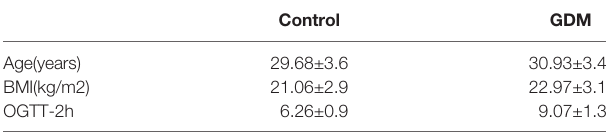
TABLE 1 | Basic characteristics of study population according to